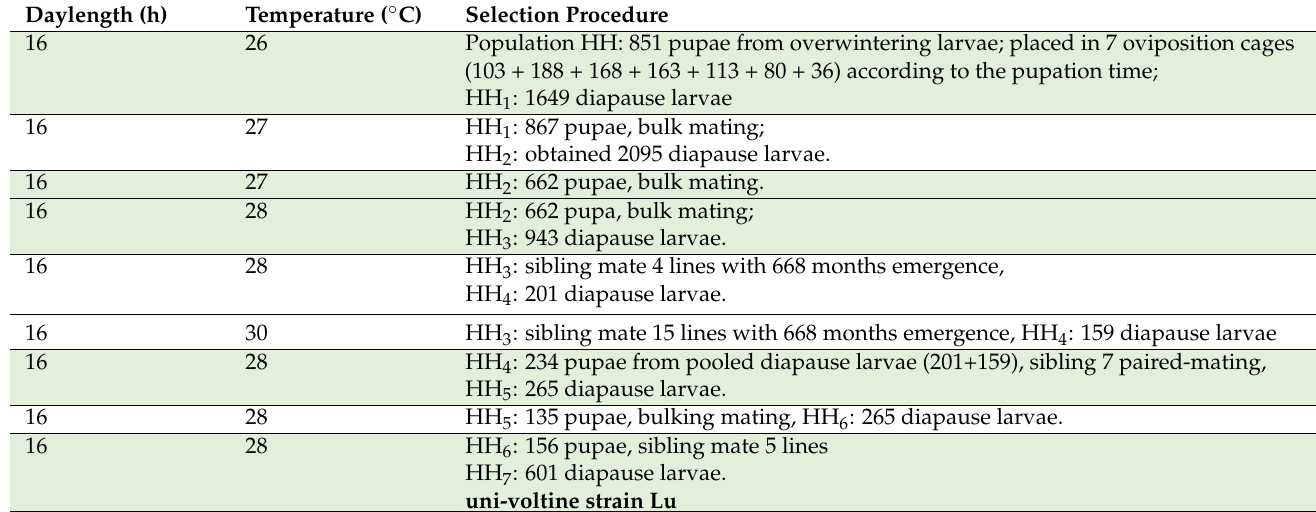
Table A1. Selection procedure used to establish a univoltine strain Lu of Ostrinia furnacalis